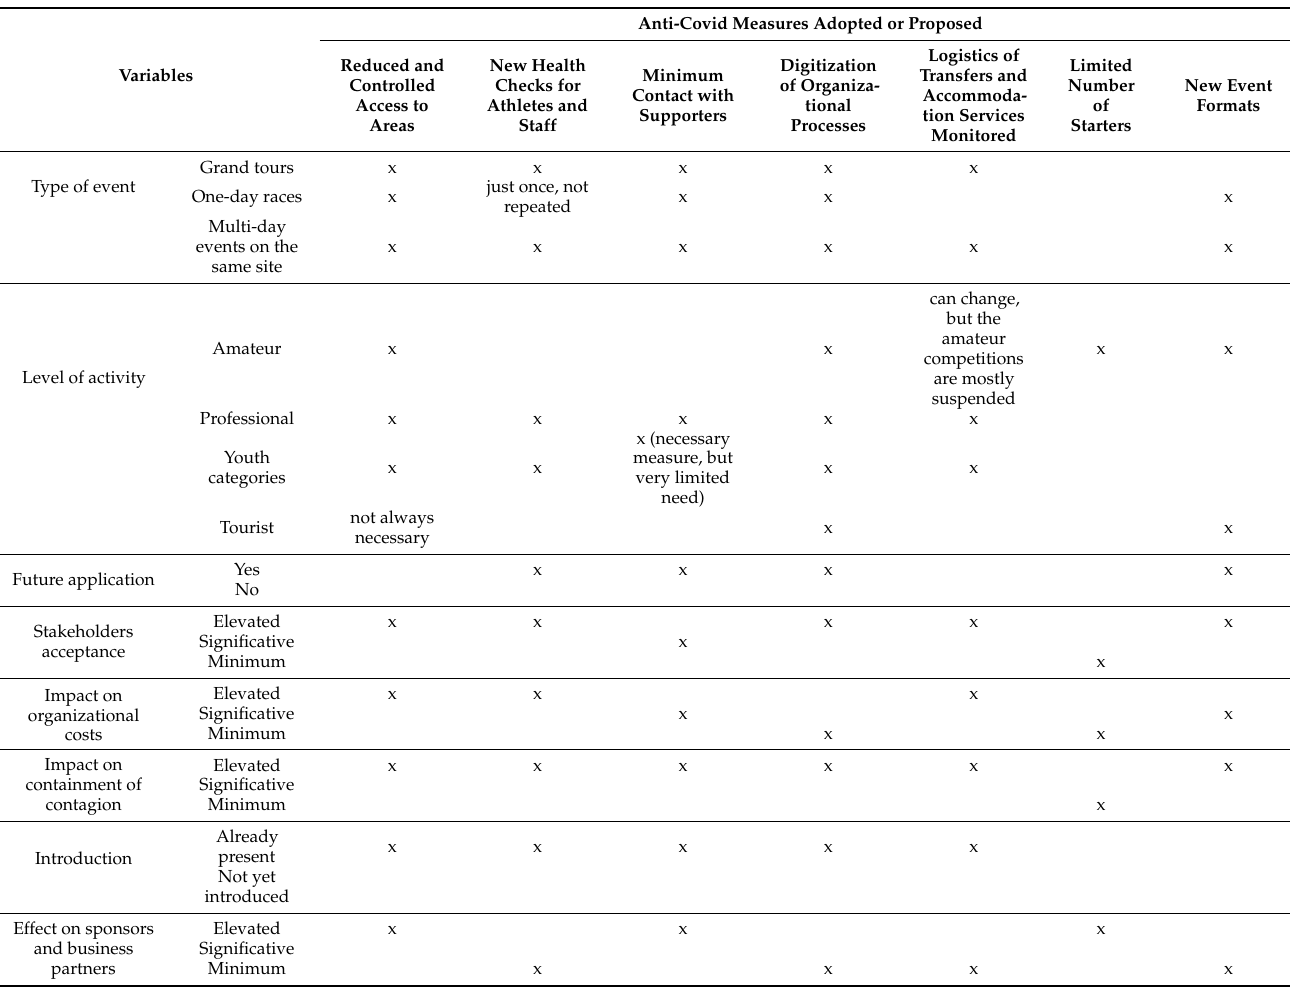
Table 4. Dynamic relationships between anti-covid measures and analysis